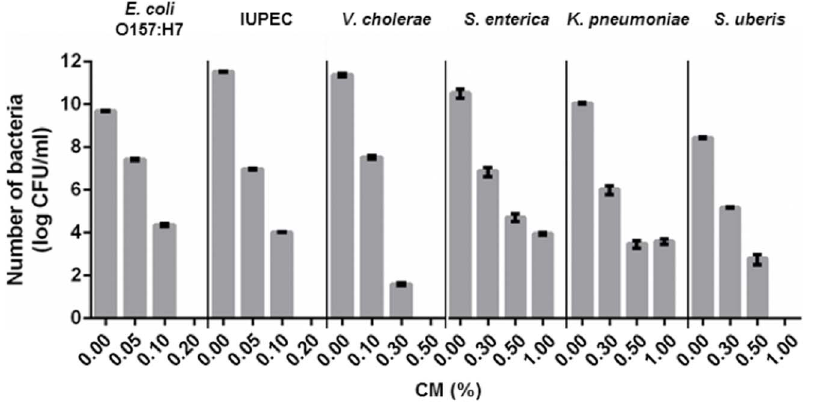
Figure 4. A broad antimicrobial activity of chitosan microparticles. Various strains including E. coli O157:H7, Intrauterine pathogenic E. coli (IUPEC), V. cholerae, S. enterica, K. pneumoniae, S. uberis were treated with CM at different concentrations and viable cells were measured after 6 h treatment; Mean values 6 SEM are plotted from three independent experiments.